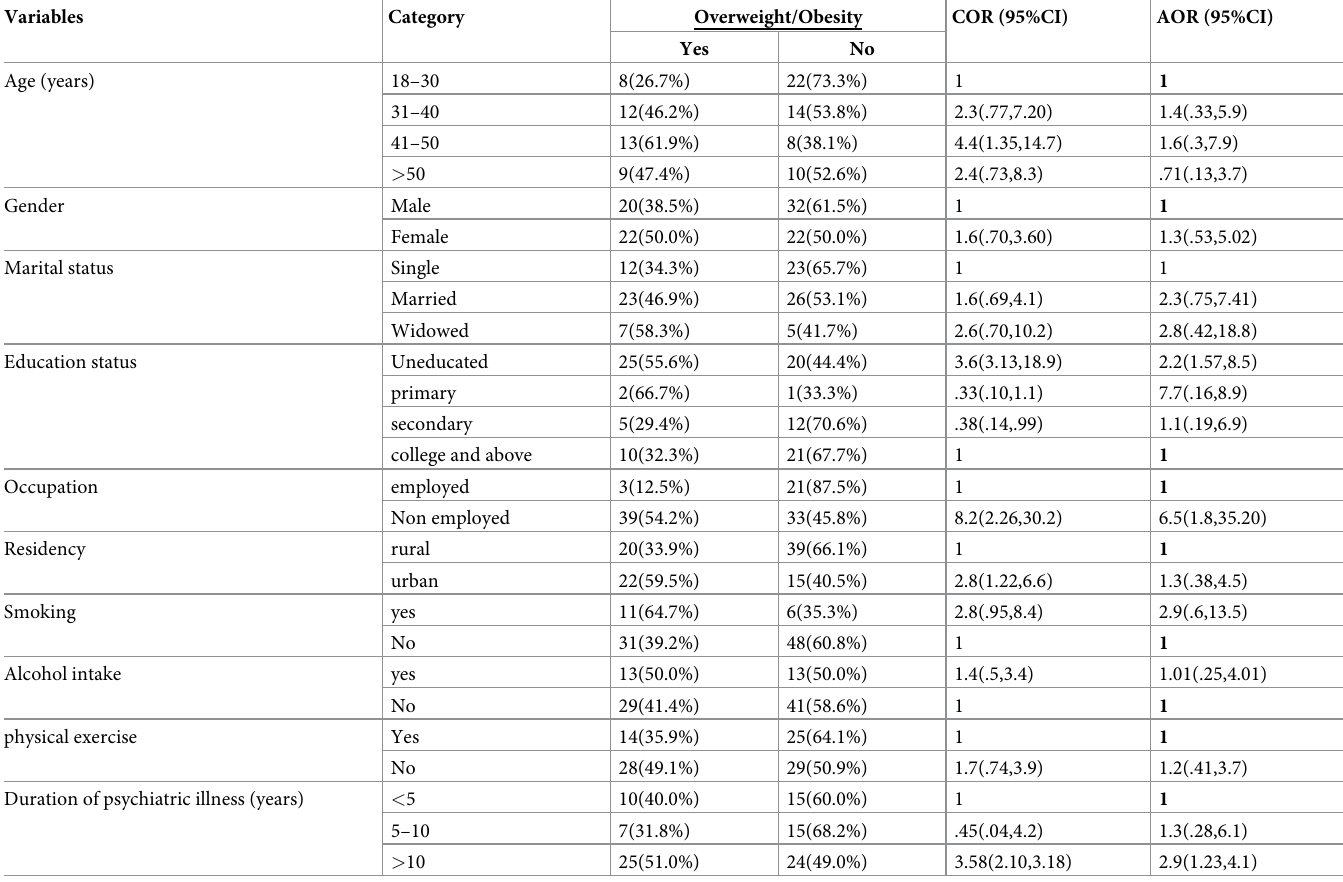
Table 2. Factors associated to overweight/ obesity among severely ill psychiatric patients, Dire Dawa, Eastern Ethiopia,